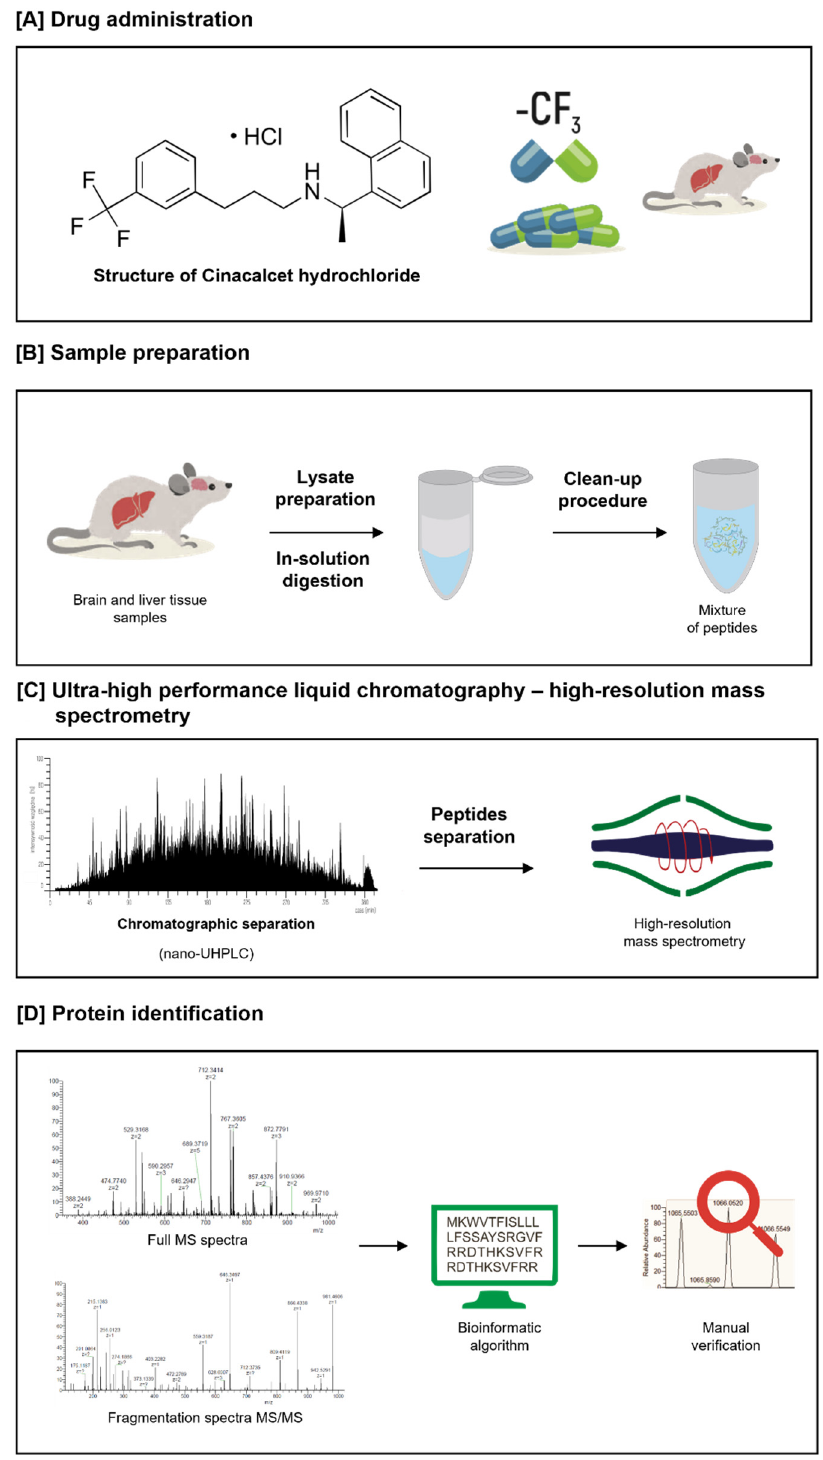
Figure 2. Experimental proteomics workflow for identification of proteins and verification of the presence of fluoridated peptides: ( A ) Cinacalcet drug administration; ( B ) Sample preparation to proteomic analysis; ( C ) Chromatographic peptides separation by ultra-high liquid chromatography (nano-UHPLC) and analysis by high-resolution mass spectrometry; ( D ) Data analysis including peptide/protein identification with the Mascot search algorithm and manual inspection of an exper- imentally generated MS/MS spectrum with the theoretical MS/MS spectrum of identified fluori- nated peptides.